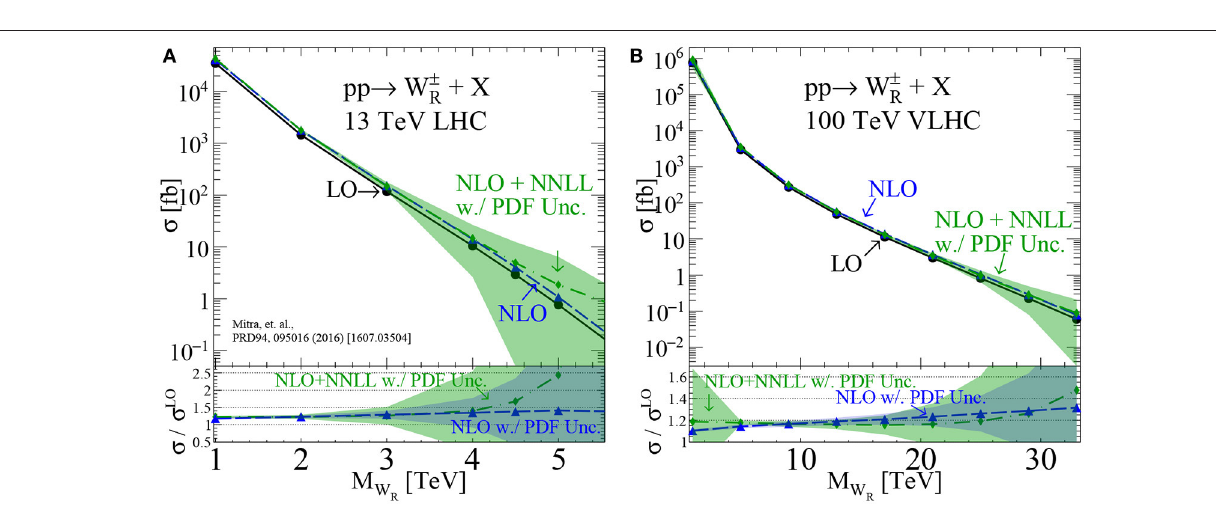
FIGURE 17 | Upper panel: As a function of M W (dash-dot) with 1 σ PDF uncertainty (shaded); Lower: NLO (dash) and NLO+NNLL (dash-dot) K -factors and PDF uncertainties [